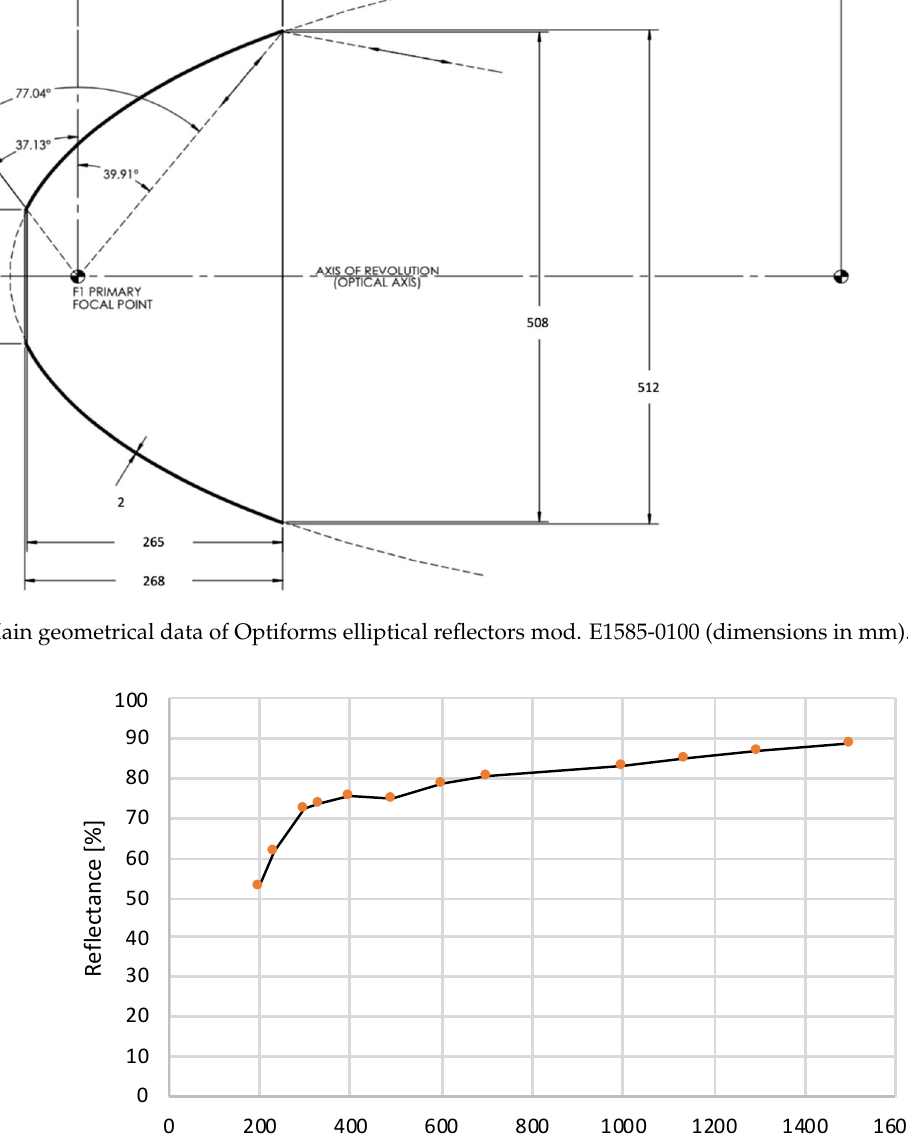
Figure 3. HFSS CAD model: external and internal view.